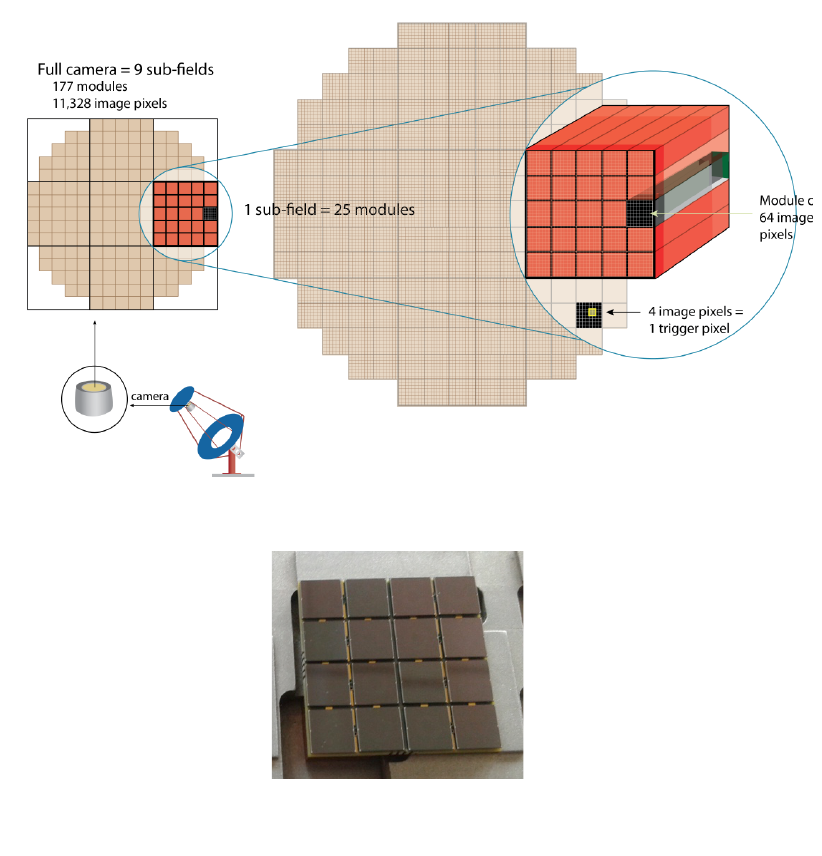
Figure 1. Top: scheme of the focal plane of the pSCT telescope. Bottom: Photo Detection Unit (PDU) made of 4 4 ×